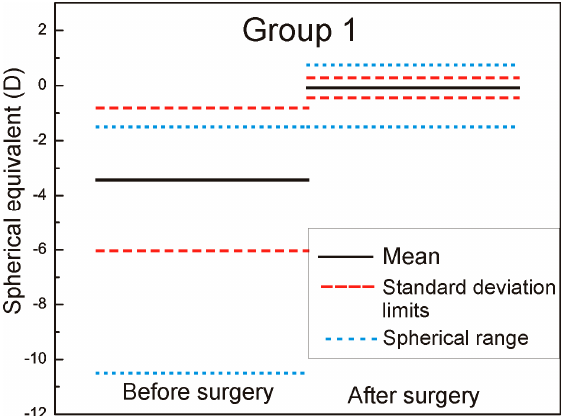
Figure 1. Refractive spherical equivalent pre- and postoperative Group 1.